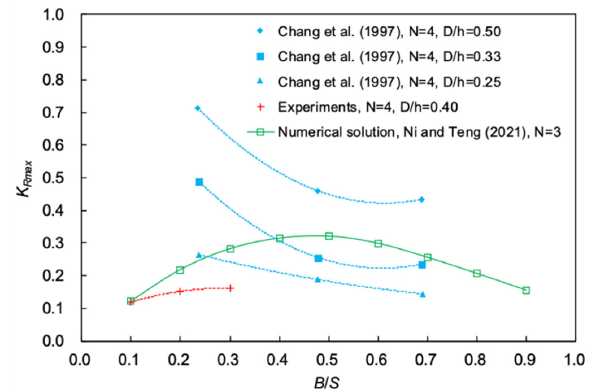
Figure 12. Comparison of Bragg resonant reflection coefficient peak K Rmax with relative width B / S (Chang et al. [42], Ni and Teng [29]).